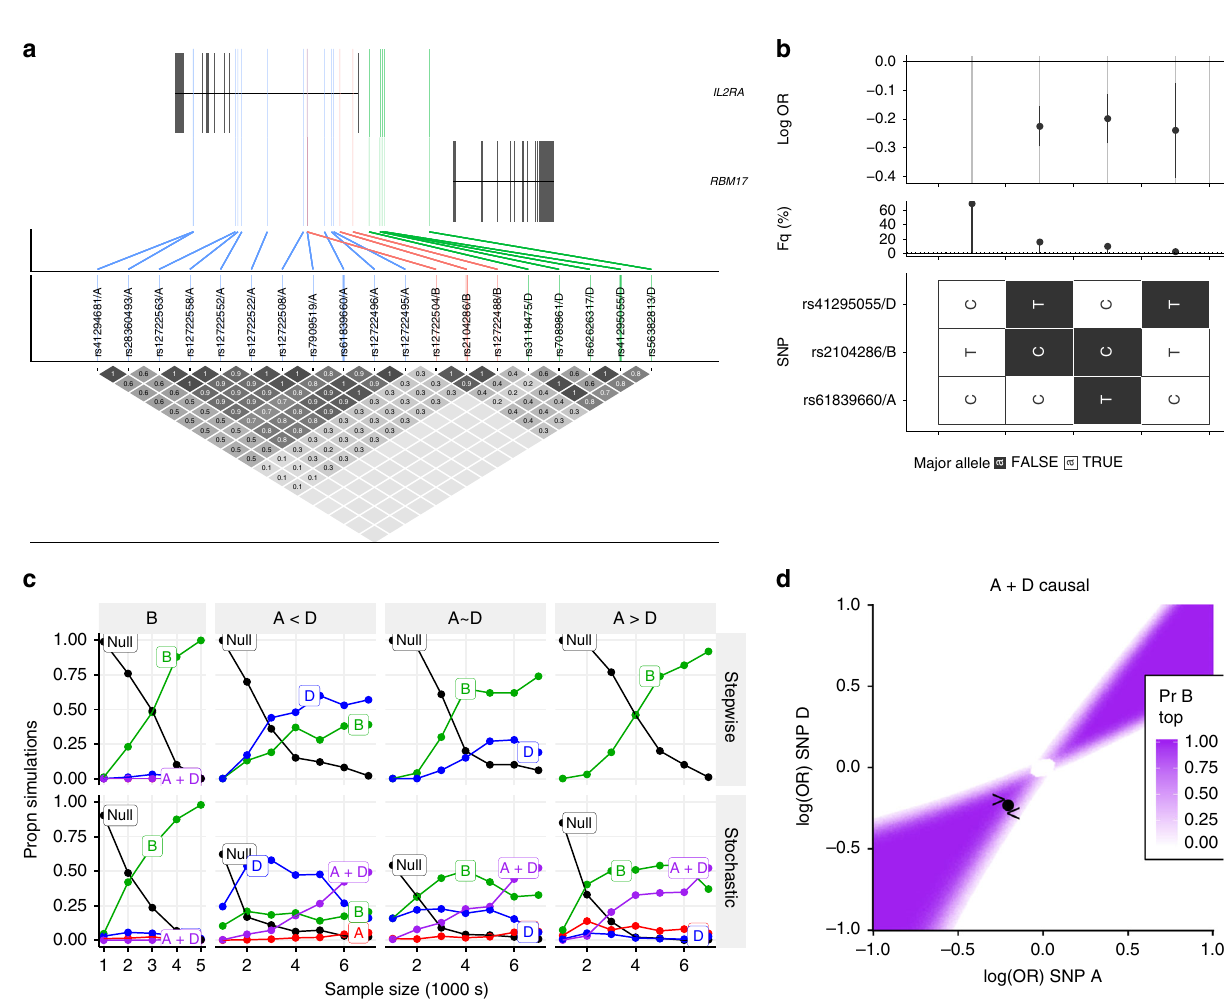
Fig. 6 Analysis of chromosome 10p region containing IL2RA a Map showing positions of SNPs (GRCh37) in groups A, B and D. SNPs in the same group are in high LD, with colour used to indicate group membership. b Haplotype analysis of SNPs selected by stepwise search and GUESSFM for MS. Each row represents one SNP, with possible alleles colour coded according to major or minor. Each column is a haplotype — a speci fi c combination of alleles across all SNPs — with frequency in UK controls and effect on disease risk (log OR + 95% CI). There are four common haplotypes. Three appear protective, carrying the minor allele at either A or D, but only two carry the minor allele at B. c Comparison of stepwise and stochastic search applied to simulated data. Causal variants were simulated as follows: B: single causal variant B, OR = 0.8; A < D causal variants A + D, odds ratios A:0.84, D:0.77; A~D: causal variants A + D, odds ratios A:0.81, D:0:8 (observed in MS data); A > D: causal variants A + D, odds ratios A:0.77, D:0:84. Potential models include A (red), B (green), D (blue), A + D (purple) and null (black); any other models are grouped together as grey. The y -axis shows the proportion of simulations in which the stepwise approach chose the indicated model (adding SNPs while p < 10 -6 ) or the average posterior probabilities for each model for the stochastic search approach. Sample size ( x -axis) is the number of cases and controls. d Assuming A and D are causal, this plot shows the probability that B has the smallest p-value as a function of the effect sizes (log odds ratios) at A and D. The estimated effects for A and D from MS data are shown by a point, and the simulations from c by < and > for A < D and A > D conditions respectively. Source data for c are provided in Supplementary Tables 7,